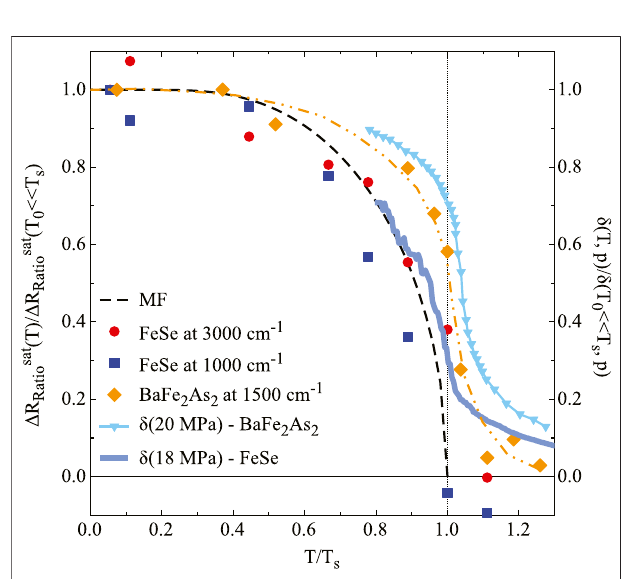
FIGURE4| (coloronline) T dependenceof Δ R sat ratio (i.e.,opticalanisotropy at saturation, see text): at 1,000 and 3,000 cm − 1 in FeSe for p bellows = 1.2 bar (i.e., p sample ≈ 18.5 MPa),read from Figure3 . Δ R sat ratio isnormalized byits value at T 0 = 5 K. The same quantity at 1,500 cm − 1 for BaFe 2 As 2 [28], normalized at T 0 = 10 K, isshown with dashed-double dot lineas guide to the eyes. With respect to the normalized view of Δ R sat ratio in FeSe, it is worth reminding that as shown in Figures 2A , 3 Δ R ratio > 0 and Δ R ratio < 0 at 1,000 cm − 1 and at 3,000 cm − 1 , respectively. Δ R sat ratio at FeSe is compared to the T dependence of the mean- fi eld order parameter (dashed line). The stressed-induced orthorhombicity ( δ ) at typical stress for fully detwinned specimens (i.e., at saturation) is reproduced from Ref. [35] for BaFe 2 As 2 and estimated for FeSe [36], respectively. The T axis has been normalized by T s ~ 90 and 135 K for FeSe and BaFe 2 As 2 (vertical dotted line), respectively. Reproduced from Ref.